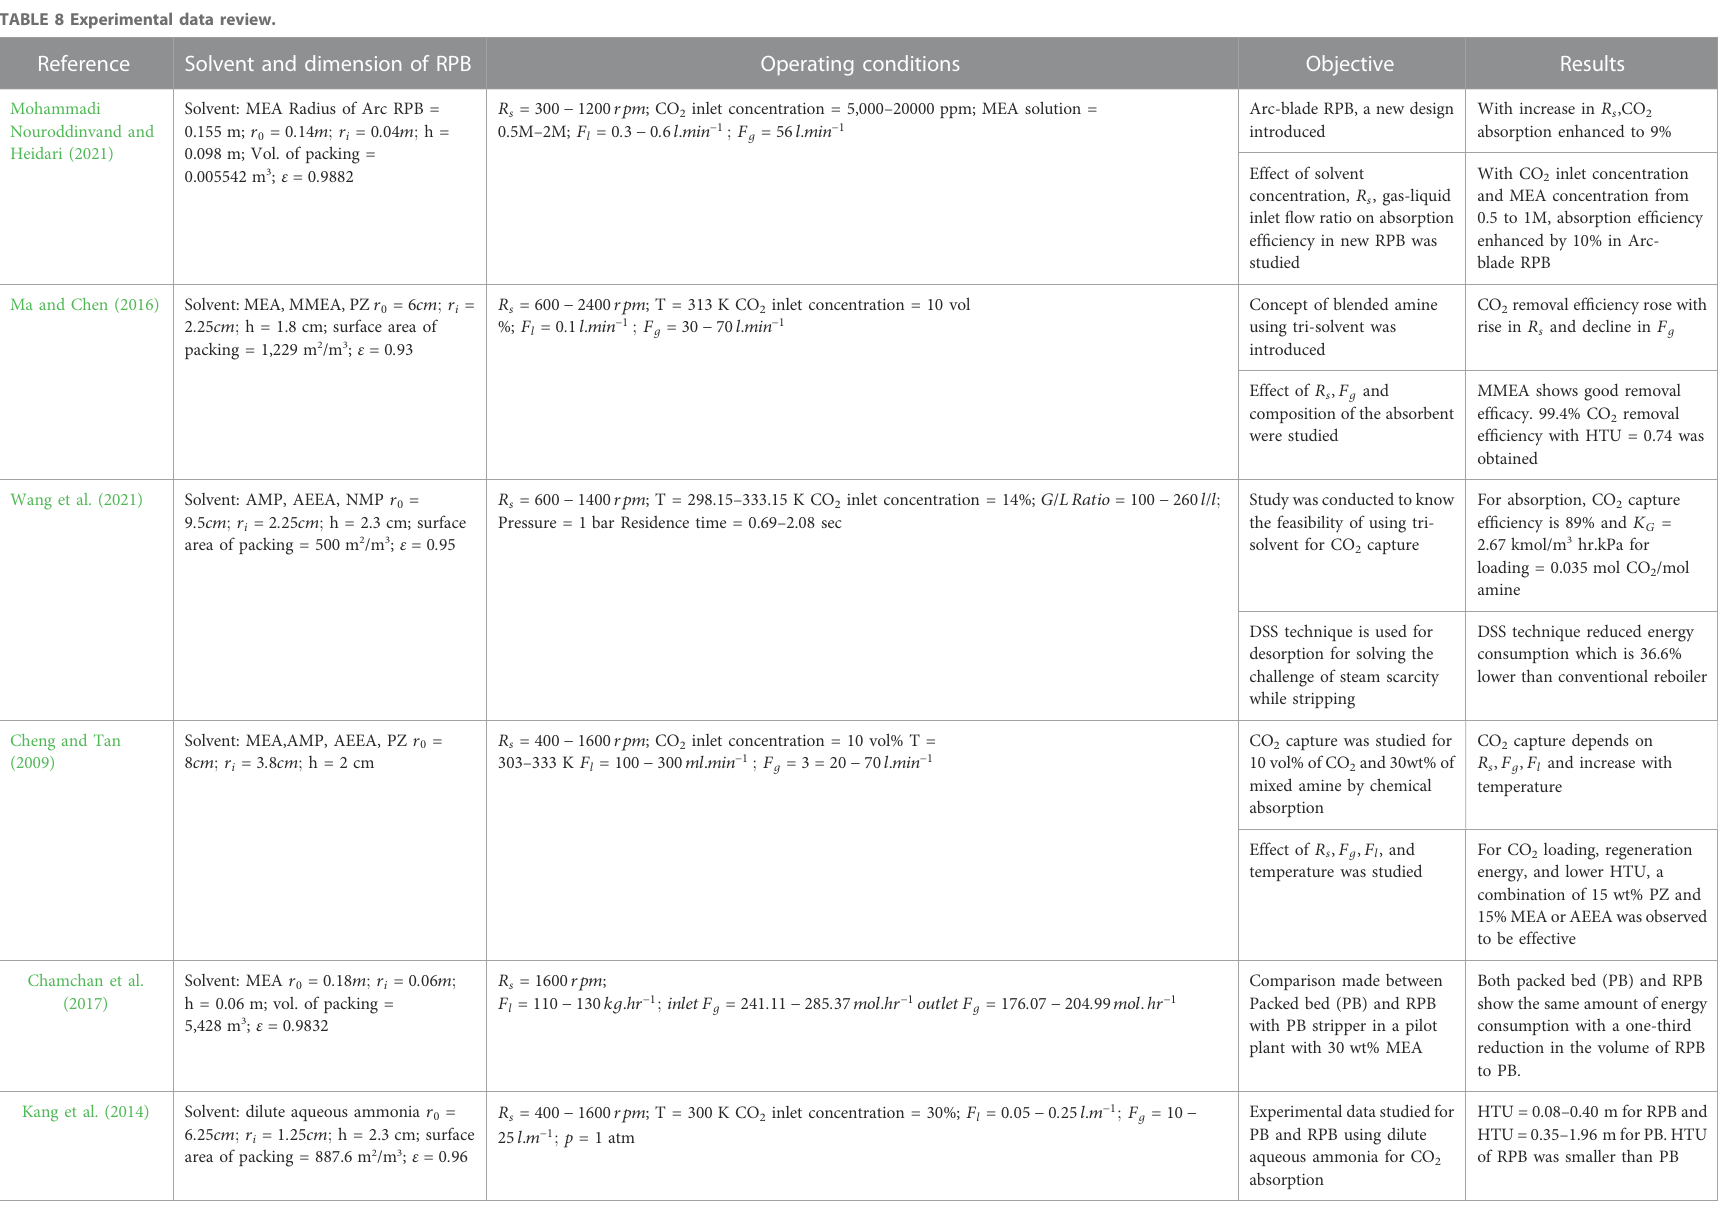
TABLE 8 Experimental data